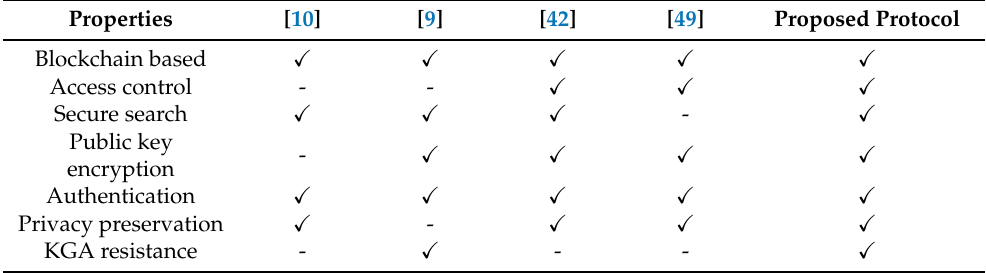
Table 2. Comparison of security properties.